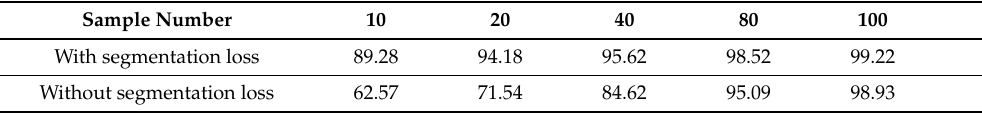
Table 10. Ablation experiments of segmentation labels.